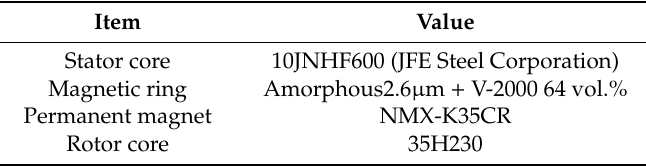
Table 2. Material